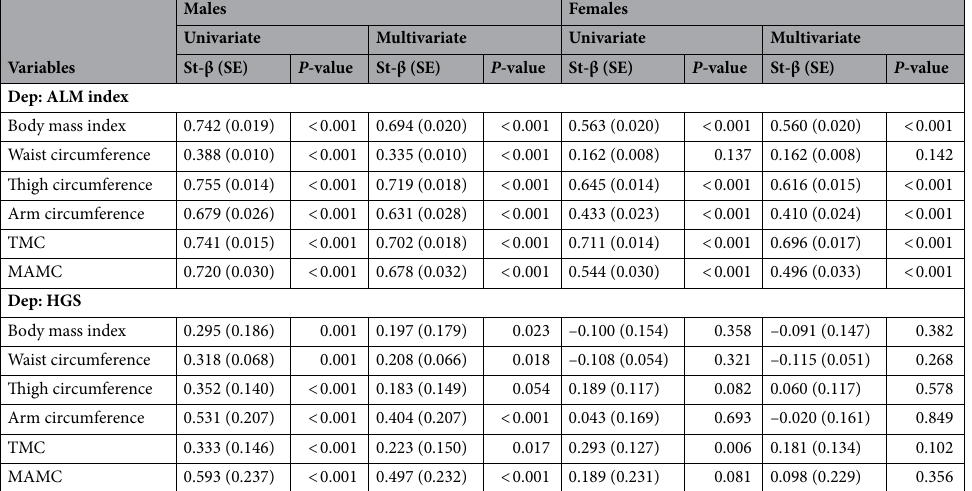
Table 2. Results of linear regression analyses of variables for predicting appendicular lean mass index and handgrip strength. Multivariate analyses were adjusted for age, presence of diabetes mellitus, weekly Kt/V urea , urine volume, serum albumin, C-reactive protein, and use of automated peritoneal dialysis. Abbreviations: St-β, standardized β; SE, standard error; Dep, dependent variable; ALM, appendicular lean mass; HGS, handgrip strength; MAMC, mid-arm muscle circumference; TMC, thigh muscle